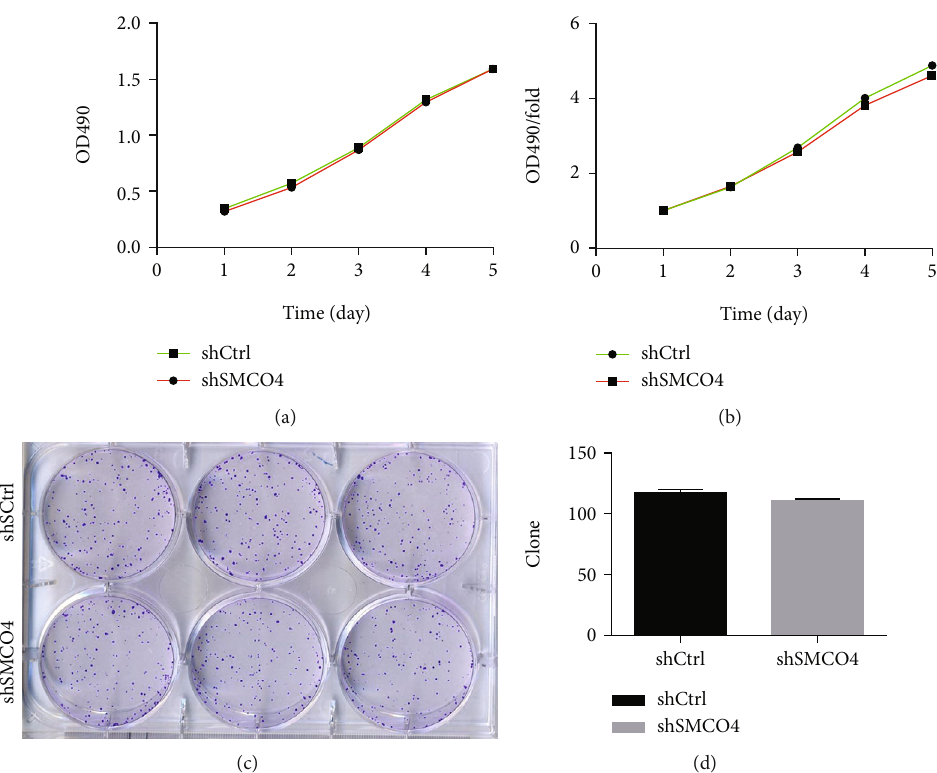
Figure 7: E ff ect of SMCO4 knockdown on the proliferation of the Eca109 cells. (a and b) MTT assay was used to evaluate the e ff ect of SMCO4 knockdown on the proliferation of the Eca109 cells. (c and d) The clone formation assay was applied to observe the e ff ect of SMCO4 knockdown on the proliferation of the Eca109